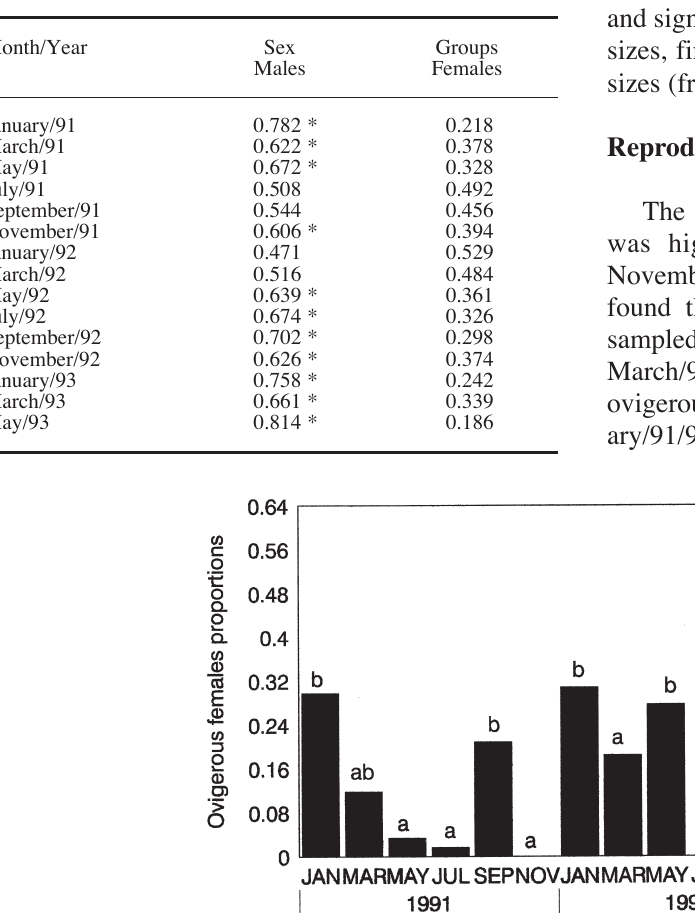
T ABLE 1. – Comparison of the sex-ratio of C. ornatus sampled from Jan/91 to May/93 in the Ubatuba (SP) region of Brazil, analyzed by Multinomial proportions test. (The proportion without asteriks in the line means no difference between male and female,